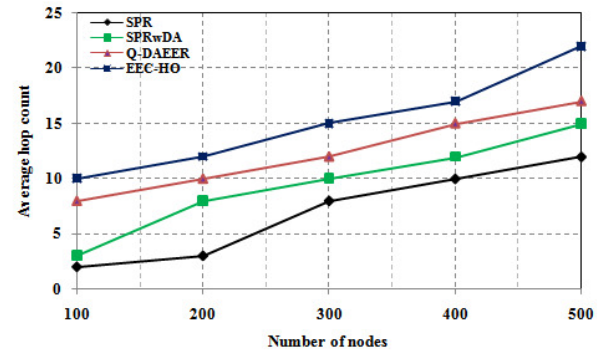
Figure 4. Average hop count with number of nodes